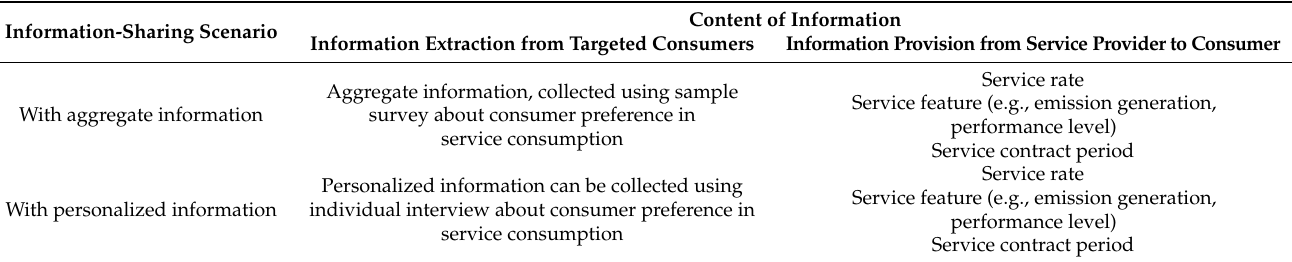
Table 2. Influential factors of consumer’s decisional